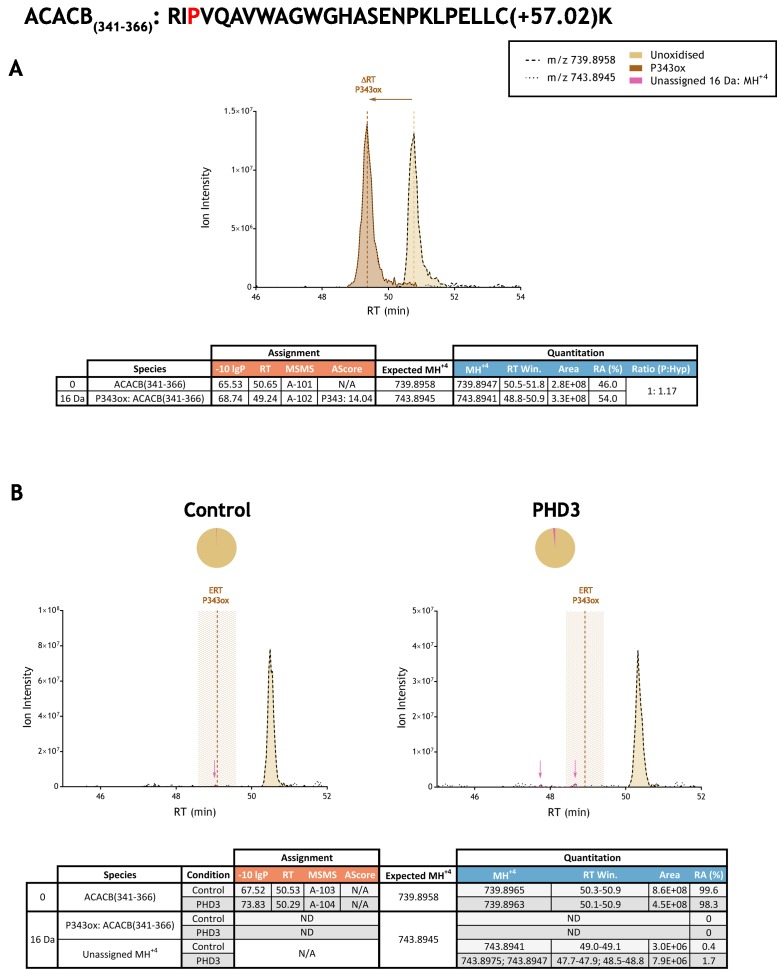
Quantitation of peptide oxidation on ACACB(341-366) following reaction of full-length acetyl-CoA carboxylase 2 with recombinant PHD3.XIC data presented in (A) shows ion intensity and retention time (RT) characteristics of equimolar synthetic peptide standards for unoxidised and P343ox forms of the ACACB(341-366) peptide. MSMS assigned species are coloured (see inset); vertical dashed lines define peak maxima used to derive ΔRT values for P343ox. Panel (B) shows comparable XIC data for protease-digested IVTT substrate under control (left) or PHD3-reacted (right) conditions. Peaks corresponding to unoxidised ACACB(341-366) were assigned by MSMS (see inset for colour code); P343ox was not detected. The estimated RT (ERT) for P343ox, derived from (A), is indicated by dashed vertical line, shading corresponds to a 1 min RT window. Peptide ions of low abundance that were compatible with oxidation but not assigned by MSMS are also indicated (pink arrow). Quantitative data for observed species are presented as pie charts with XIC data. Assignment and quantitation data are tabulated below each panel, table headers are as follows: (−10lgP) significance score of leading assignment at given (RT) with ambiguity score (AScore) for PTM localisation and reference to primary MSMS data in Supplementary file 1. Quantitative data reports ion counts (Area) of observed masses (MH+4) integrated over time (RT Win.), expressed as relative abundance (RA). Data on detection efficiency for synthetic peptides (Panel A, P: Hyp) is an aggregated ratio of prolyl (P) to hydroxyprolyl (Hyp) species.